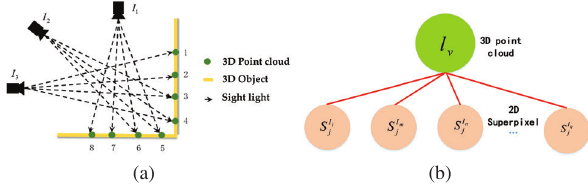
Figure 5. Construction of the graph model from the visibility model. (a) This graph shows the projection relationship between cameras and 3D point cloud in the SfM-encoded visibility model. (b) is the construction of the graph model, which express the corresponding relationship from 2D to 3D, where I ∗ represent the ∗ th image, S I ∗ ∗ indicate the superpixel in the image I ∗ .